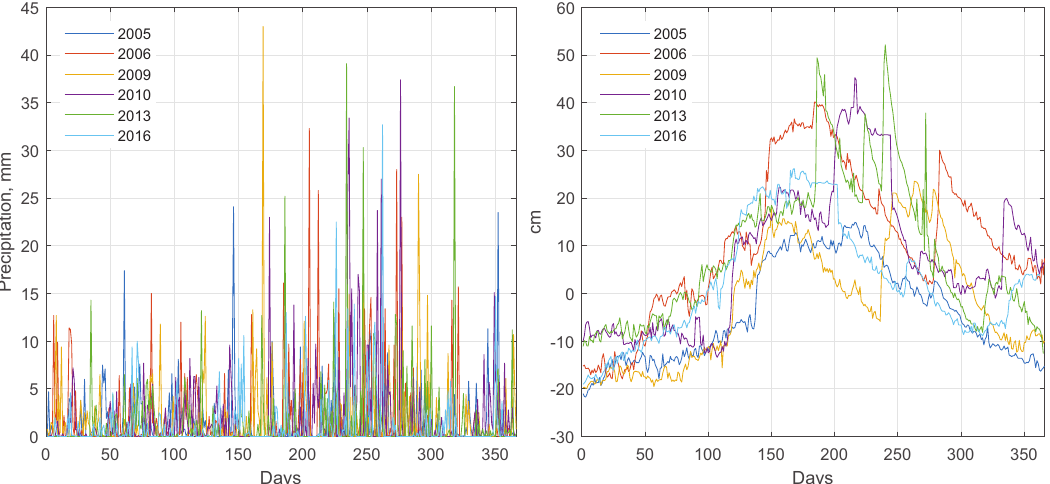
Figure 18. Time series of daily precipitation and detrended groundwater level for the selected years (the same cluster, i.e., data with similar behavior).